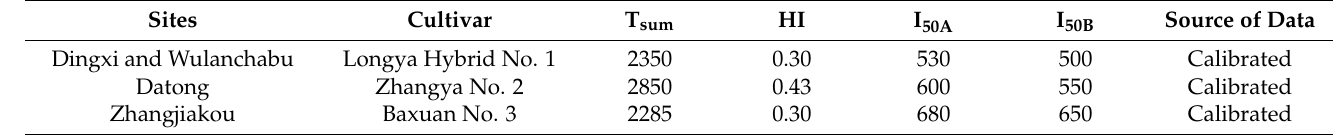
Table 4. Cultivar parameters of the SIMPLE model for flax.